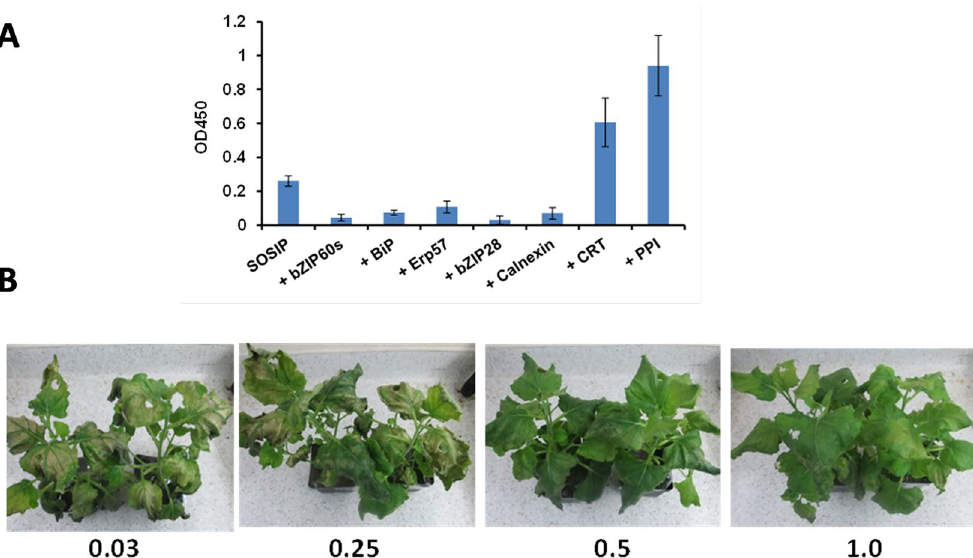
Figure 4. Effect of ER chaperones on expression in N. benthamiala and leaf pathology following co-infiltration of CH505 SOSIP chaperone genes at 10 dpi. ( A ). Enhancement of expression of the CH505 gene with individual chaperone genes. Leaf extracts were diluted sixfold. Chaperone genes were all infiltrated at OD600 = 0.2 except for Nb_bZIP60s gene, which was used at OD600 = 0.015. ( B ) Phenotypic screening of plants co-infiltrated with CH505 SOSIP and PPI at different